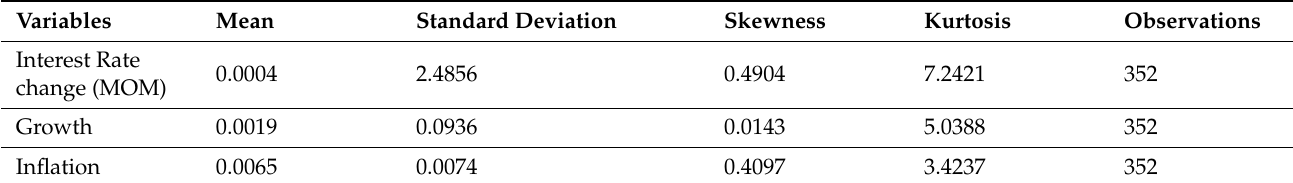
Table 1. Summary statistics.